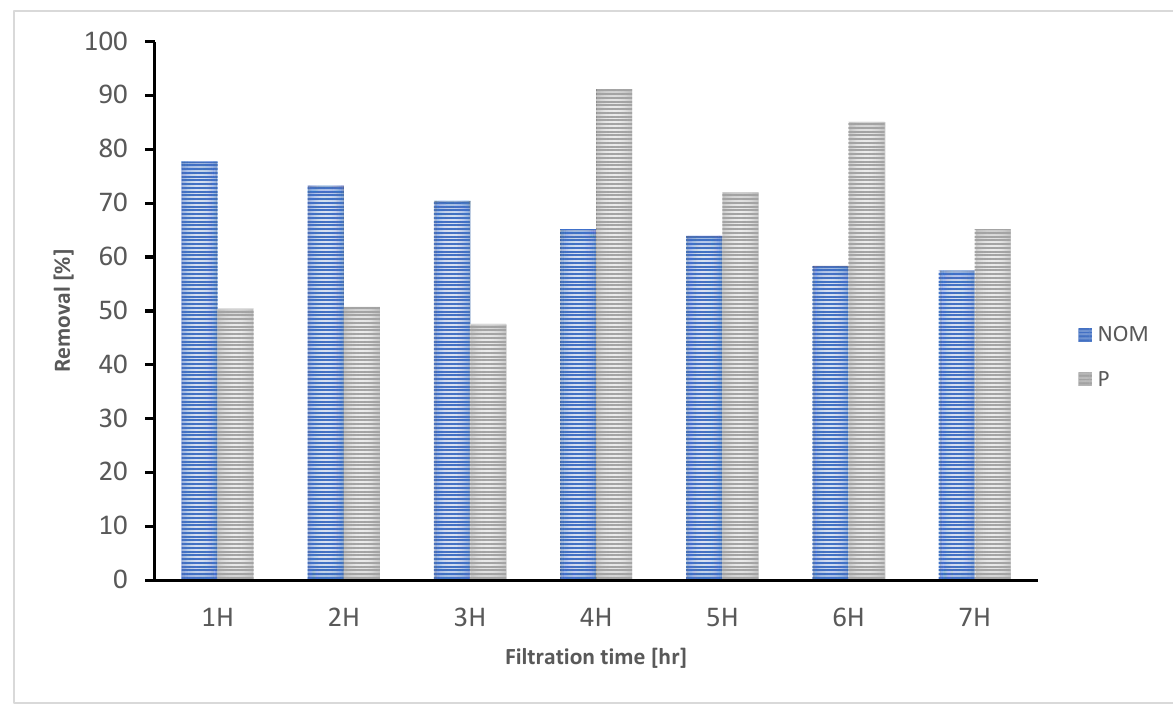
Figure 10. Removal efficiency (for the HAOPs surface loading of 17 g/m 2 as Al) during feed water filtration, NOM concentration in terms of UV-VIS254 nm was 0.2525 L/cm on average.